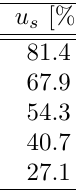
Table 4: N = 5 corresponding values of T amb = T feed and u